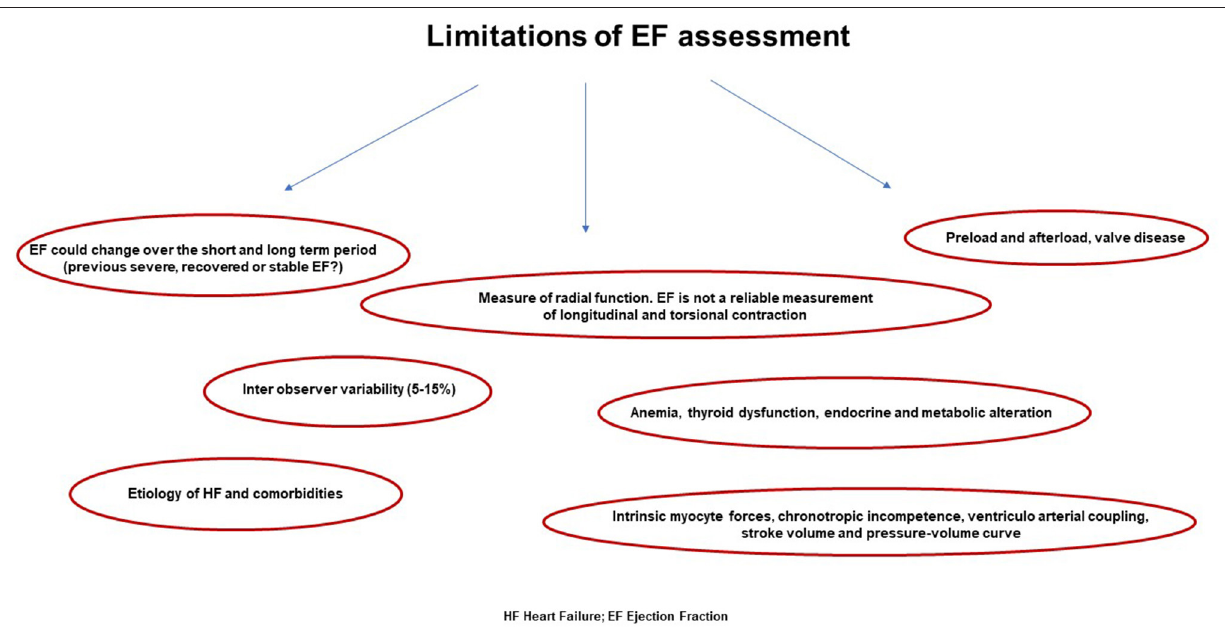
FIGURE 2 | Main weakness in ejection fraction calculation that does not comprise several features revealing the real systolic function of the left